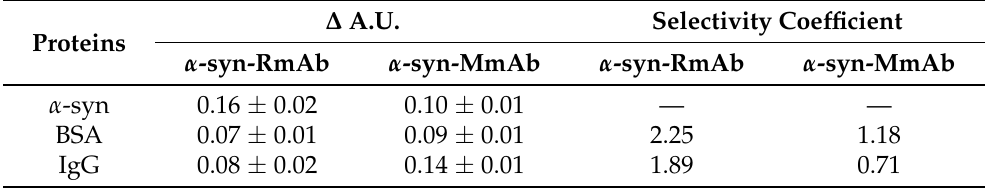
Table 1. Selectivity coefficient of the α -syn-RmAb and α -syn-MmAb on SPR sensor.